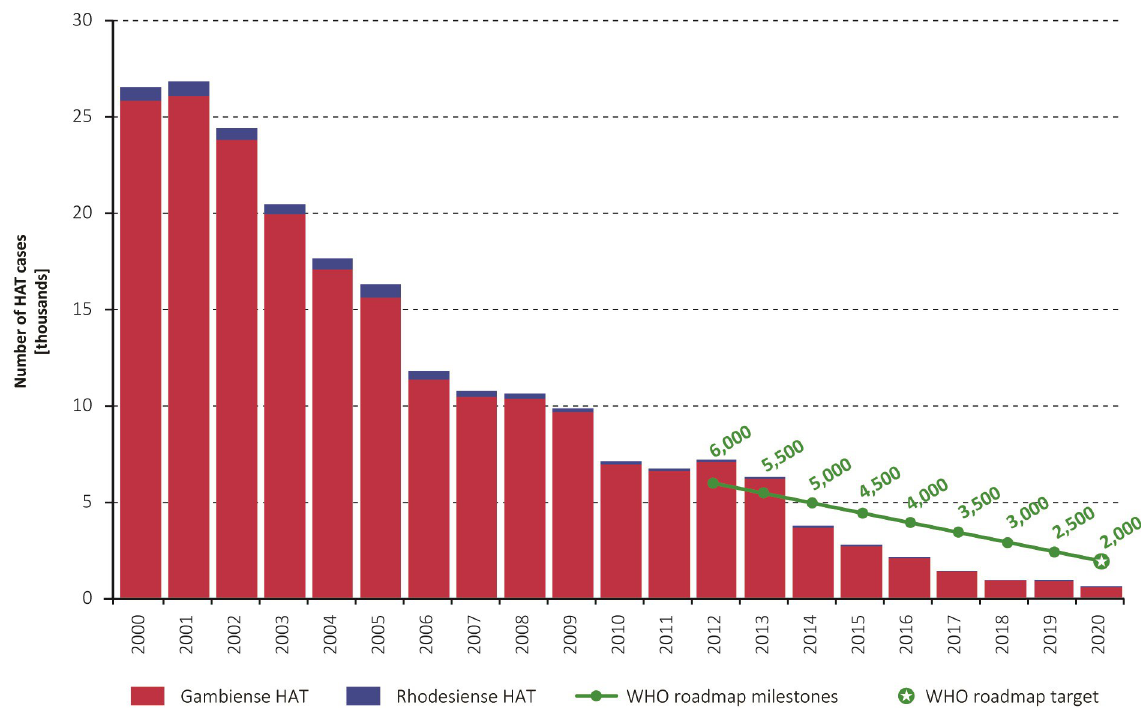
Fig 1. Total number of reported cases of HAT (gambiense and rhodesiense) per year (2000–2020). The green line and the green circles show the milestones and target set in the WHO road map for HAT elimination